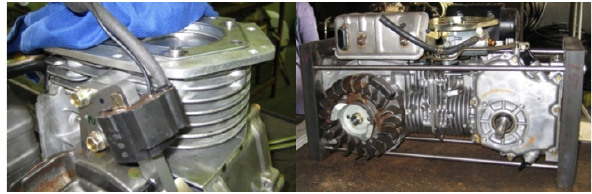
Figure 3: Detail of aluminum spacer, engine head gasket and union guides.